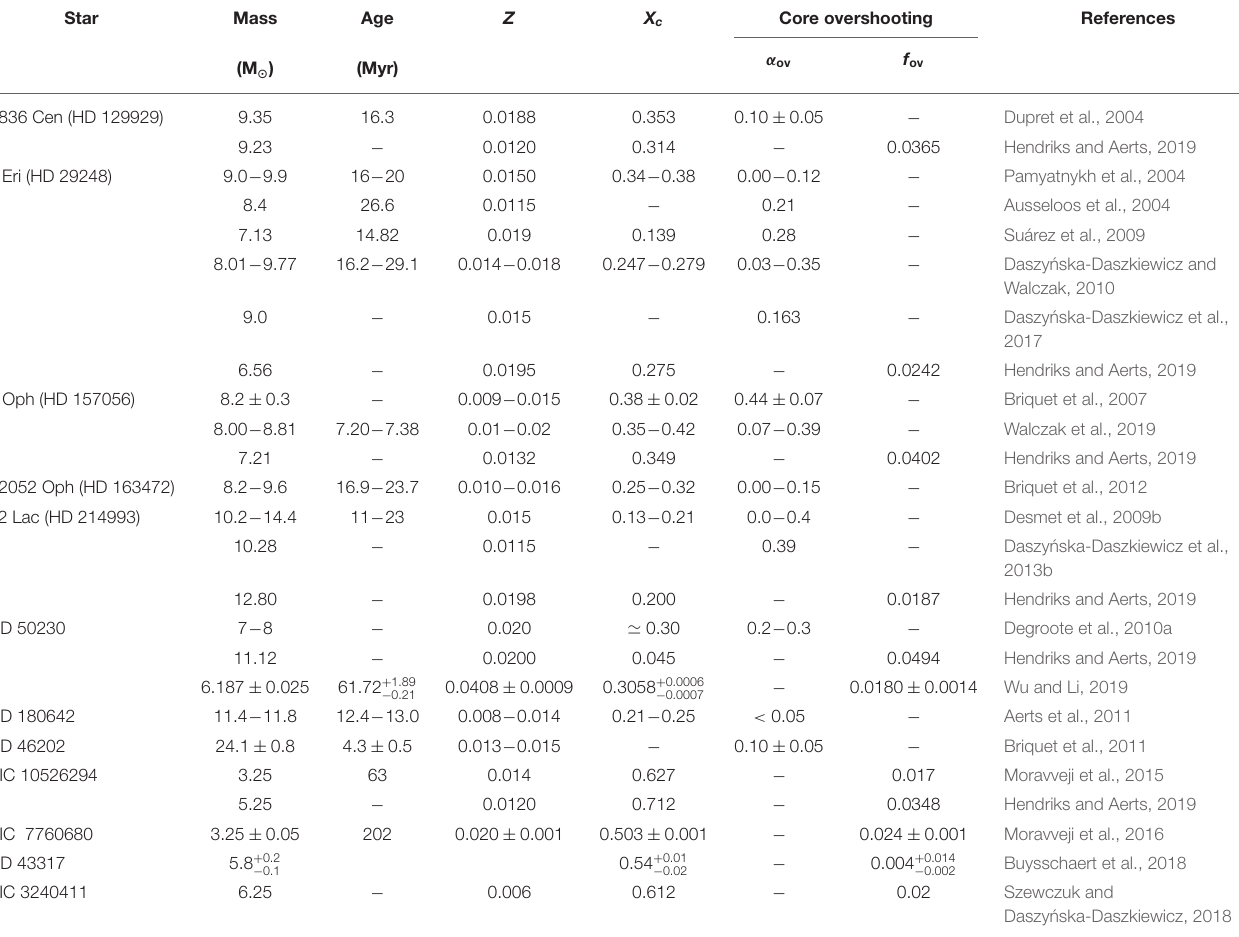
TABLE 1 | Best-fitting parameters of high-mass stars derived from forward seismic modeling of pulsations discussed in this review. Star Mass Age Z X c Core